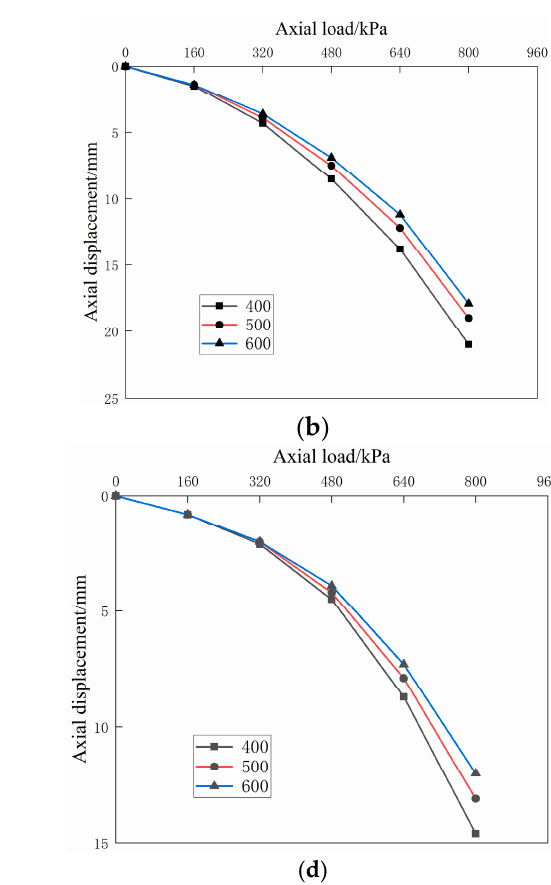
Figure 18. Each pile with different pile spacing: ( a ) variation of stress-bearing ratio, R b ; ( b ) pile-soil load-sharing ratio, R s .